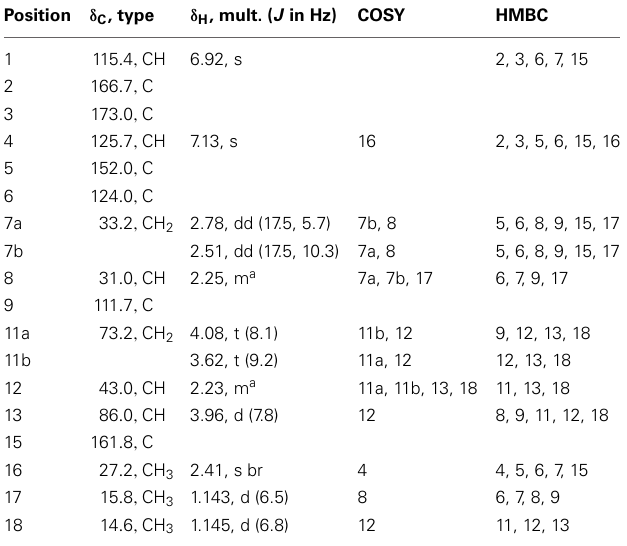
Table 3 | 1 H and 13 C NMR spectroscopic data of malettinin E (4) (600 and 150MHz) in methanol- d 4 .